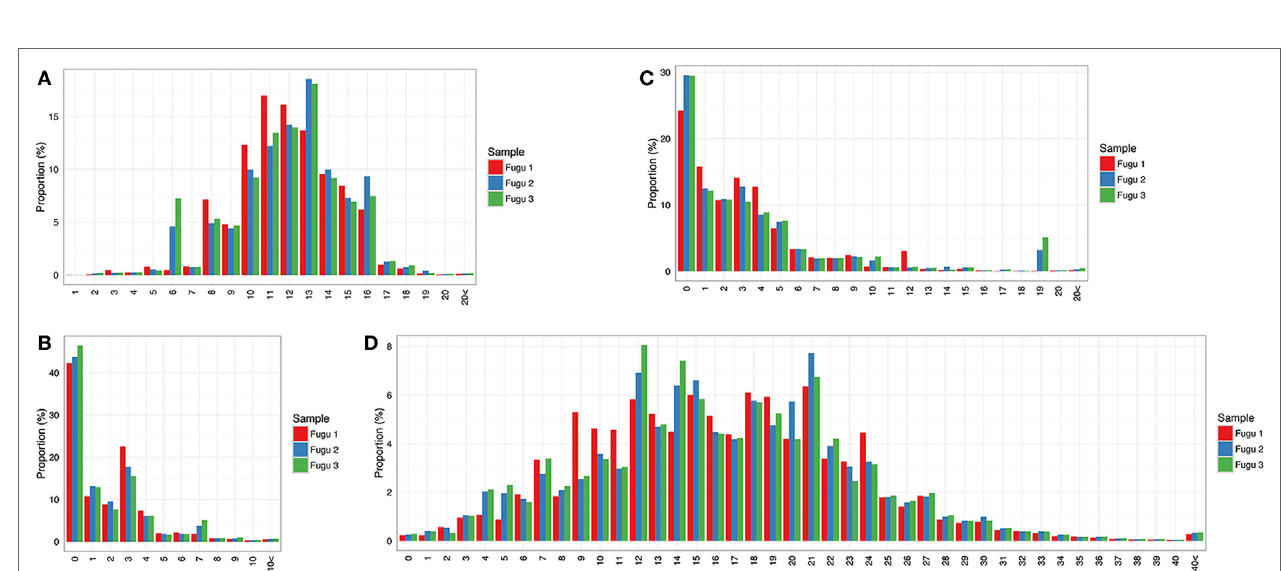
FigUre 3 | Rarefaction studies of VDJ diversity in IgM. It demonstrates that with deeper sequencing in an individual, the number of novel VDJ combinations saturates. The sampling–resampling process was performed 1,000 times for each data